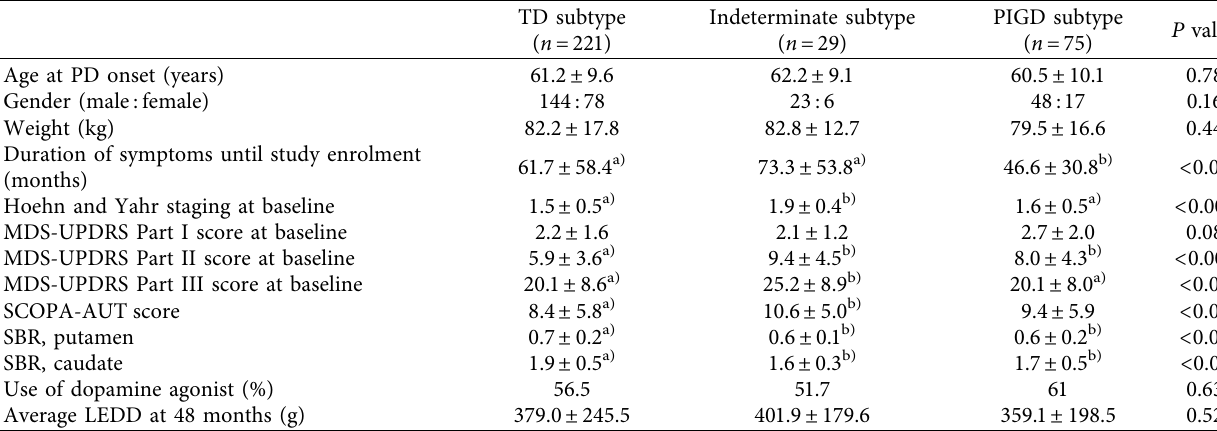
Table 1: Baseline patient characteristics.